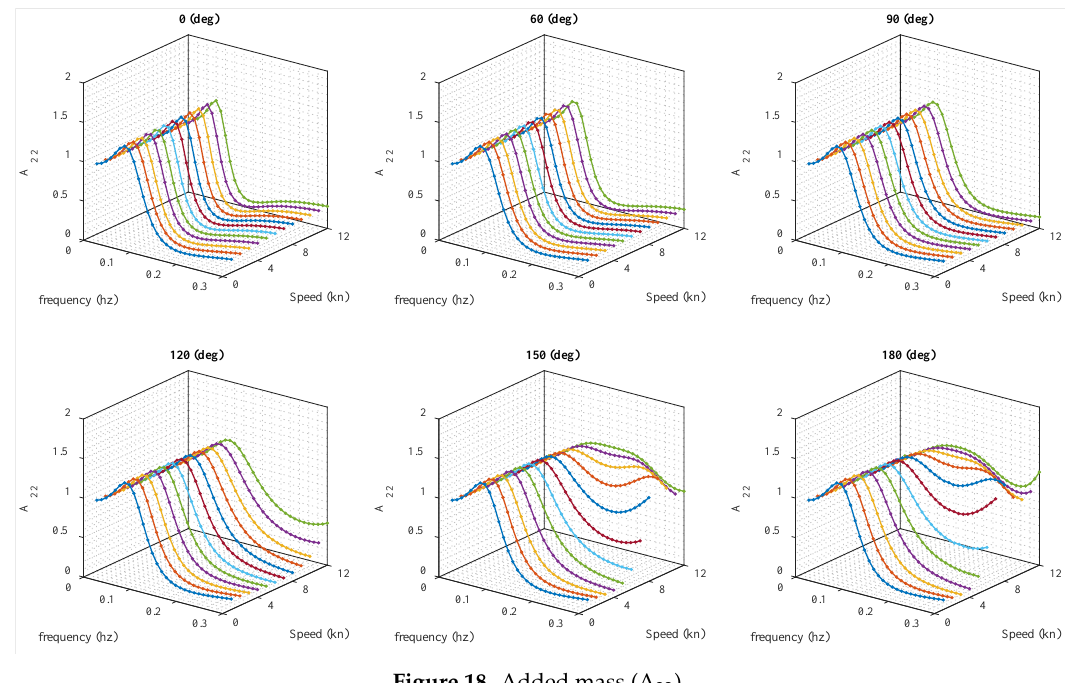
Figure 18. Added mass (A 22 ). J. Mar. Sci. Eng. 2019 , 7 , x FOR PEER REVIEW